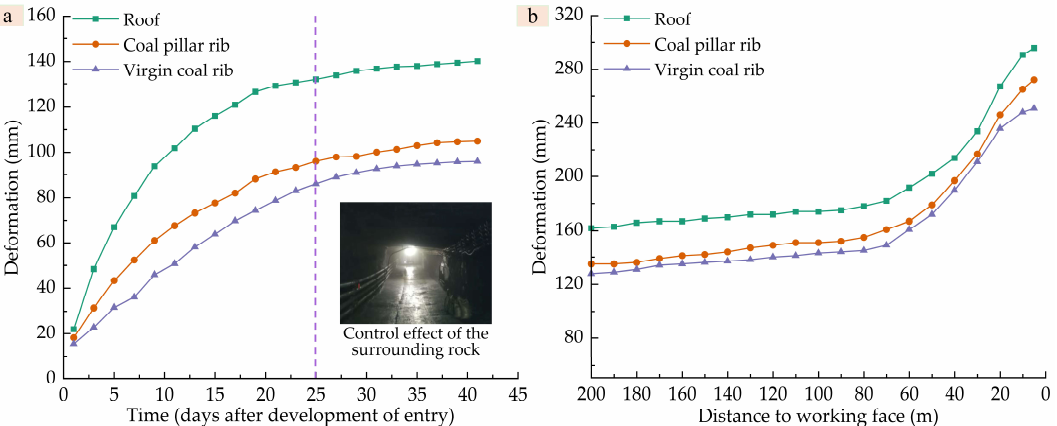
Figure 16. Deformation observation of the surrounding rock. ( a ) During roadway development. ( b ) During working face retreating.